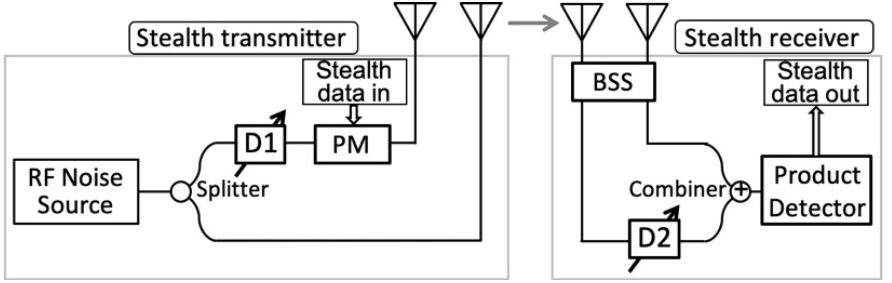
Figure 7. Wireless stealth communication system.